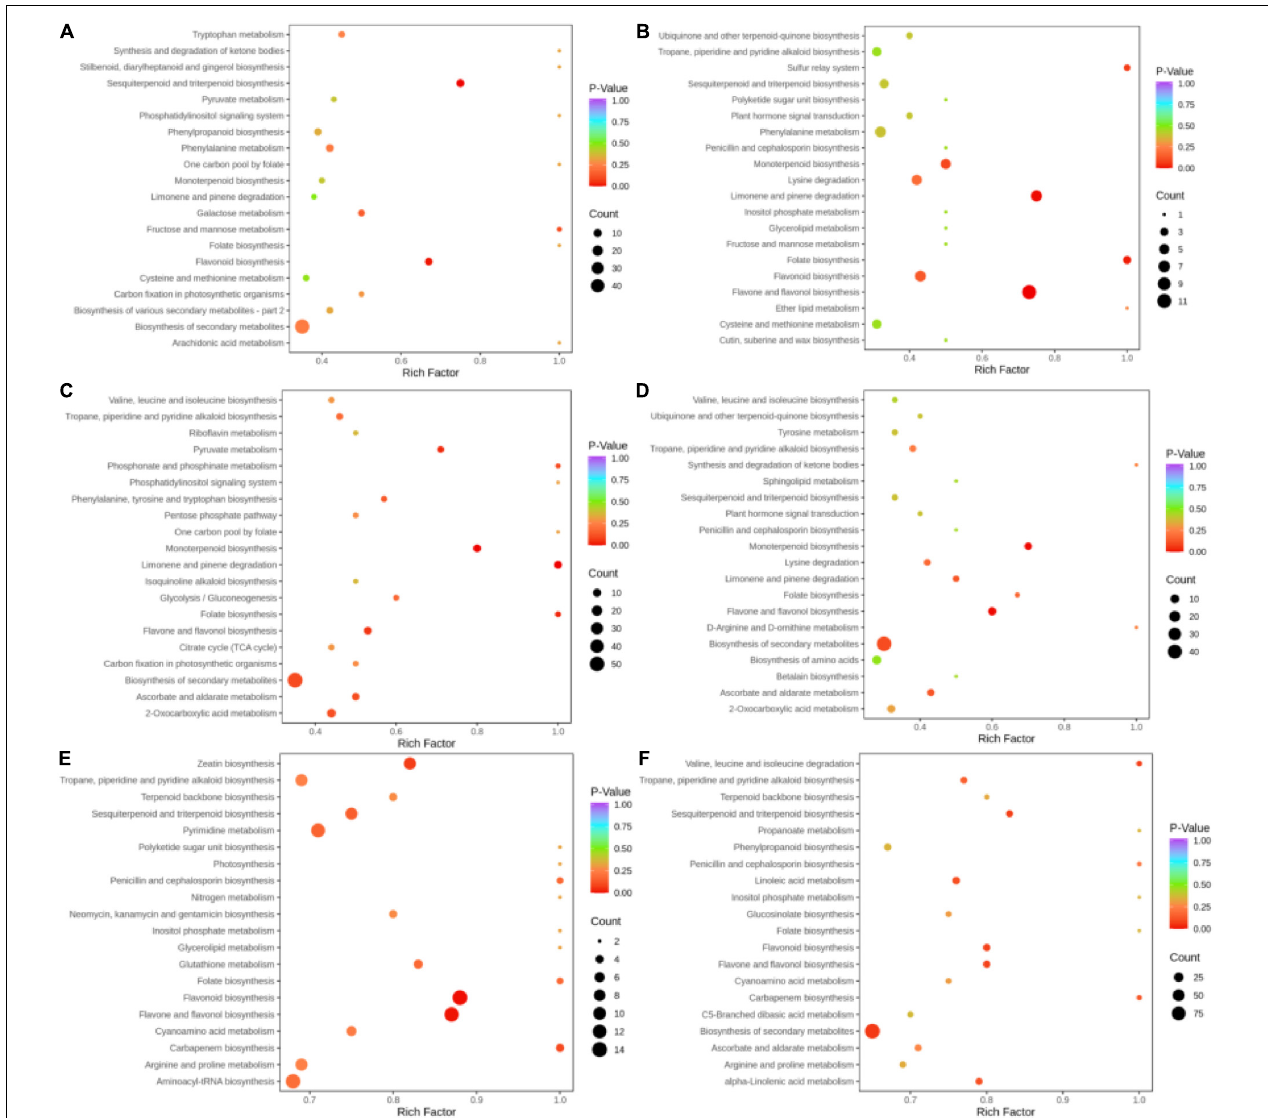
FIGURE 6 | Differential metabolite pathway bubble map. (A) BcR and BsR. (B) BcS and BsS. (C) BcL and BsL. (D) BcF and BsF. (E) BcR and BcF. (F) BsR and